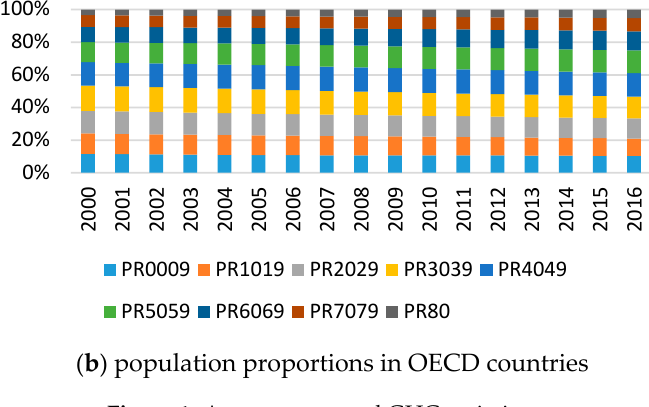
( b ) population proportions in OECD countries Figure 1. Age structure and GHG emissions. Figure 1. Age structure and GHG emissions.